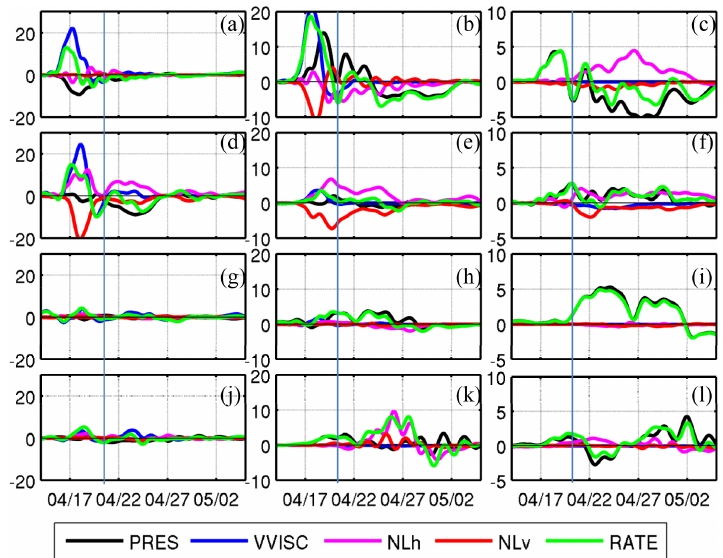
Figure 14. Time series of KEni budget at locations: A1 (a–c) , A2 (d–f) , C1 (g–i) , and C2 (j–l) in the following layers: 0–30m (left column), 30–200m (middle column), and > 200m (right column). Presented are (unit: × 10 − 3 Wm − 2 ) (a–c) VVISC, (d–f) PRES, (g–i) NL h , and (j–l) NL v